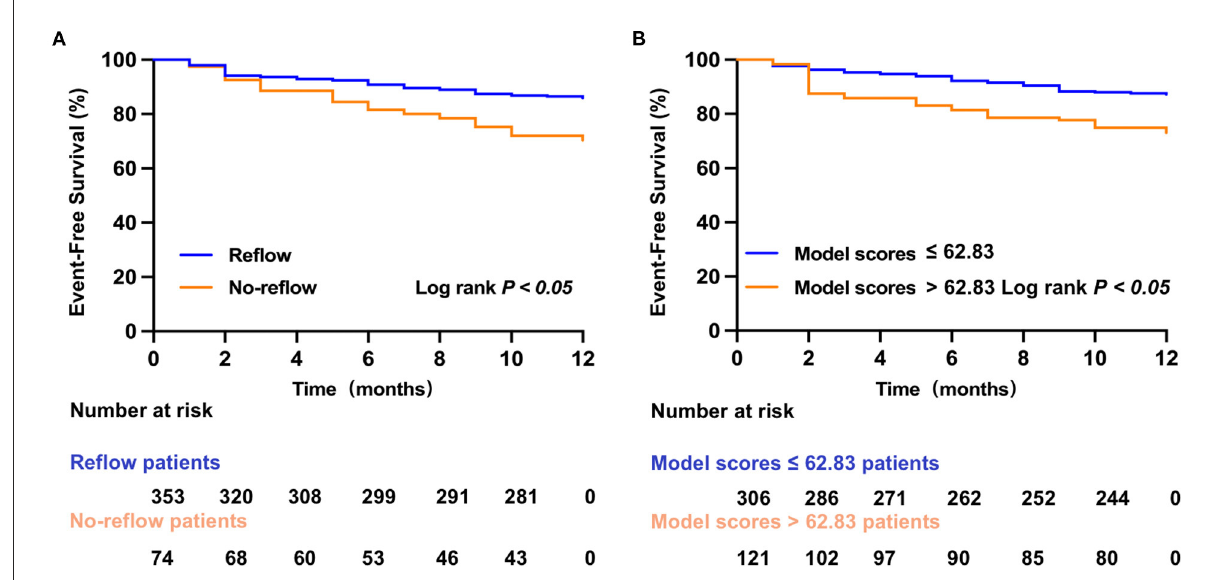
FIGURE5 Kaplan–Meier survival analysis. (A) The event-free survival for MACE in reflow and no-reflow group. (B) The event-free survival for MACE in low and high nomogram model scores group.